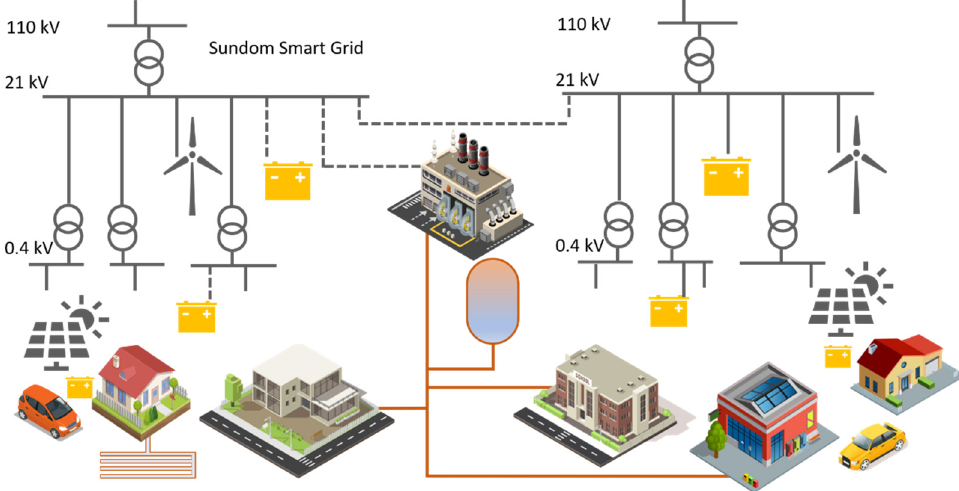
Figure 3. Outline of the developing electricity distribution networks, futuristic case of the Sundom smart grid. smart